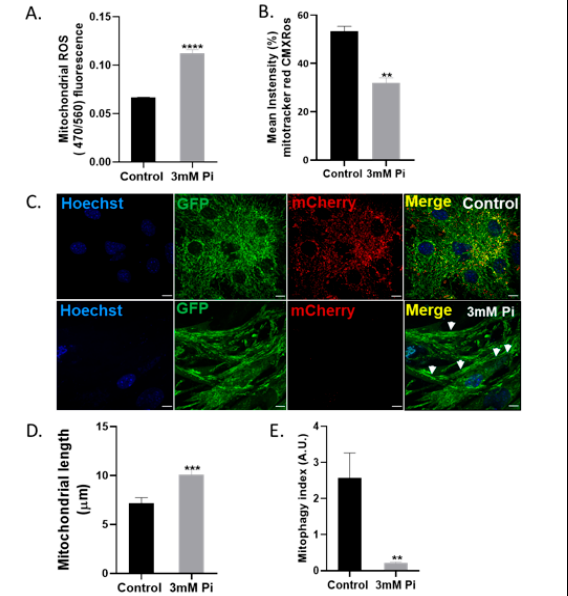
Figure 2. Mitochondrial elongation and dysfunction in calcified VSMCs. Quantification of ( A ) mitochondrial reactive oxygen species (ROS) (470/560 nm) and ( B ) mitochondrial membrane potential by mitotracker red CMXRos (mean intensity). ( C ) Representative confocal images of mito-QC VSMCs (white arrows show hyperfused mitochondria). Quantification of ( D ) mitochondrial length (µM) and ( E ) Mitophagy index. Data shown as mean +/ − S.E.M. (n = 6) ** p < 0.01; *** p < 0.001; **** p < 0.0001 compared to control. Scale bars = 10 µm.